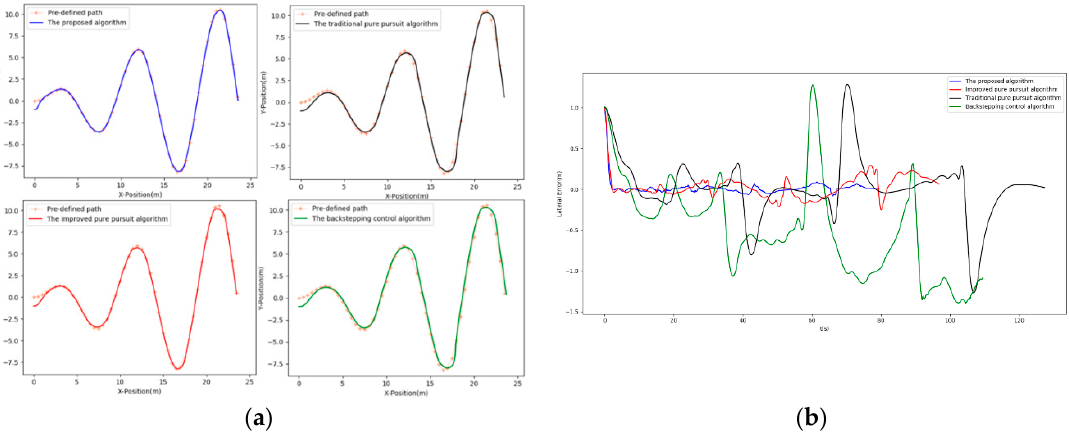
Figure 7. ( a ) Target points tracking performance on the path with multiple curvature. ( b ) Tracking lateral error under the path with multiple curvature.